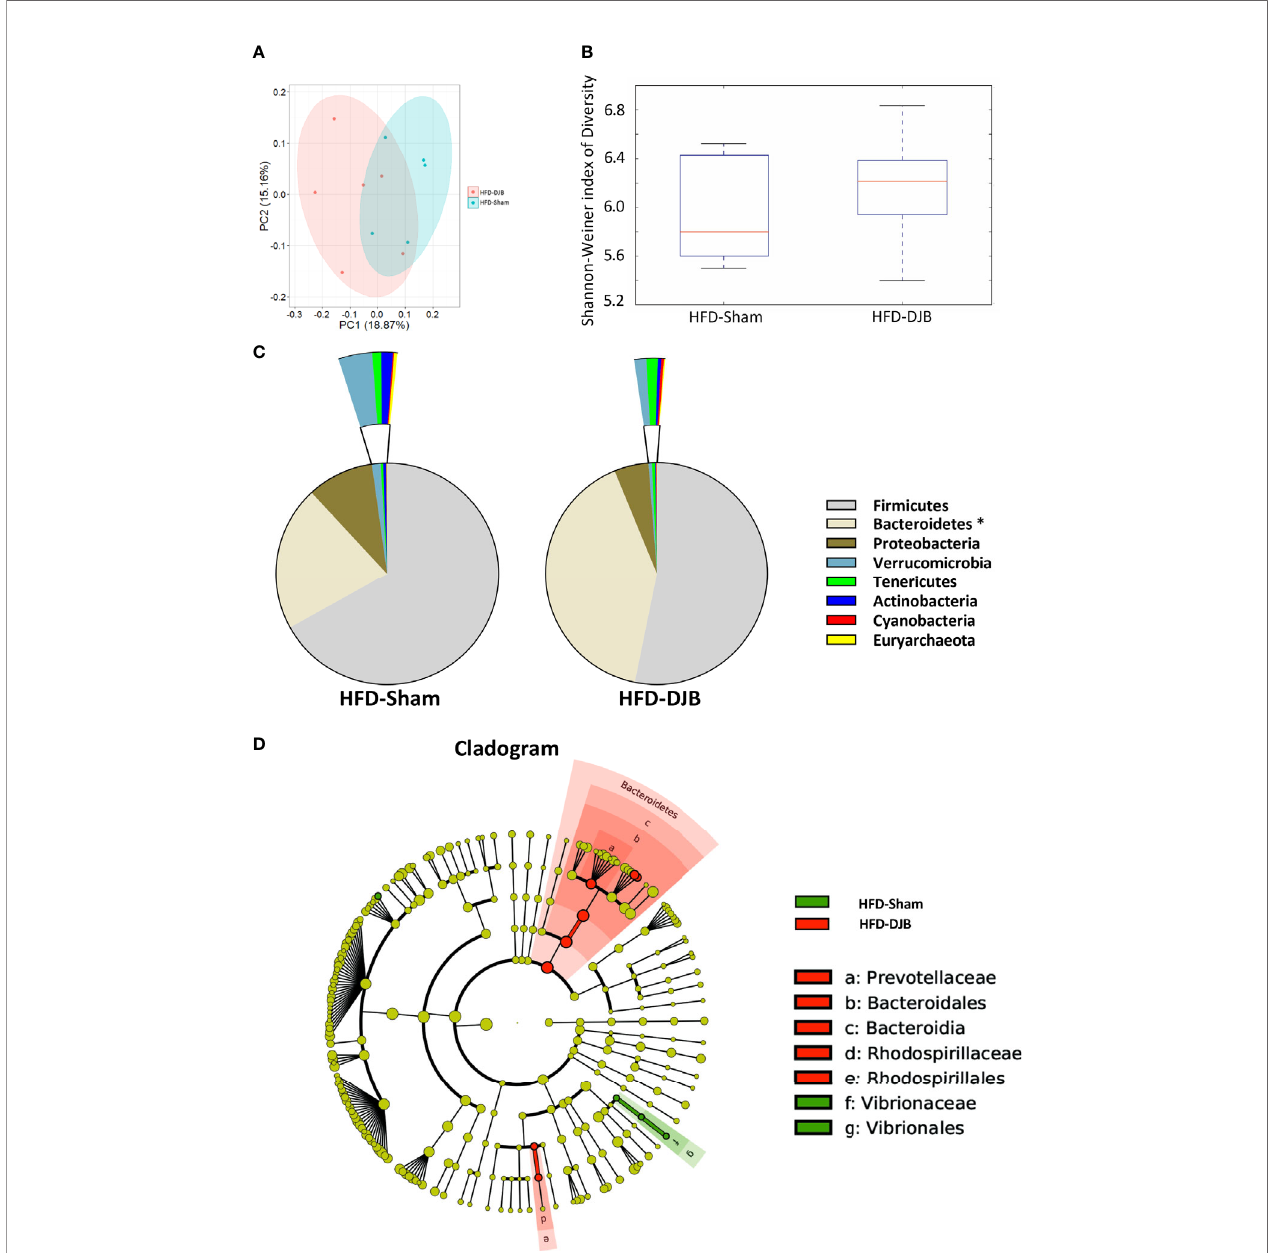
FIGURE 3 | Effects of DJB on the intestinal microbiota in HFD-fed rats. (A) PCoA plot showing the unweighted UniFrac distance between HFD-fed DJB-operated (HFD-DJB) and HFD-fed sham-operated (HFD-Sham) rats. Each rat is identi fi ed by a point. (B) Shannon-Weiner index representing the alpha-diversity in HFD-DJB and HFD-Sham rats. (C) Pie charts showing the relative abundance of phyla in the fecal microbiota of HFD-DJB and HFD-Sham rats (Kruskall Wallis test). (D) Cladogram showing the taxa most differentially associated with HFD-Sham (green) or HFD-DJB (red) rats (Wilcoxon rank-sum test). Circle sizes in the cladogram plot are proportional to bacterial abundance. The circles represent, going from the inner circle to the outer circle: phyla, class, order, family and genus. HFD-Sham, n=5; HFD-DJB, n=6. Duodenal-jejunal bypass surgery; HFD, High fat diet; OTU, operational taxonomic ( Figure 5C ). The Venn diagram of the sequenced intestinal microbiota illustrates the distribution of operational taxonomic unit (OTUs) shared by CD-fed, HFD-DJB and HFD-DJB-Tr rats: a total of 1,032 OTUs were the same ( Figure 5D ). To pinpoint the speci fi c taxa responsible for the bene fi cial effects of DJB and DJB-Tr on hepatic steatosis in HFD-fed rats, we fi rst